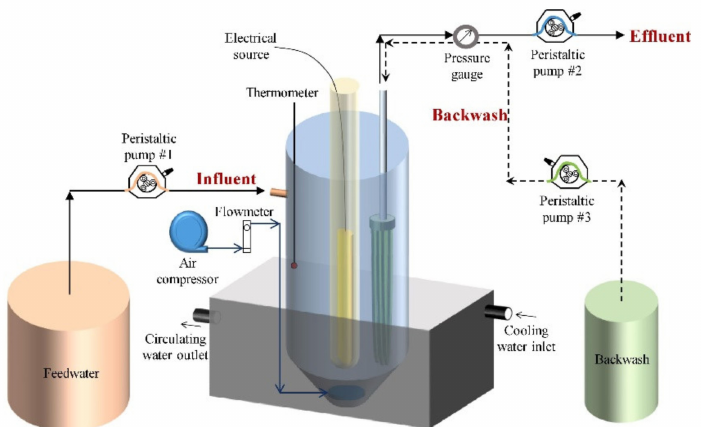
Figure 8. Schematic diagram of the combined photocatalysis-membrane filtration process used by Wang et al. Reprinted with permission from ref. [116]. Copyright © 2021 Elsevier